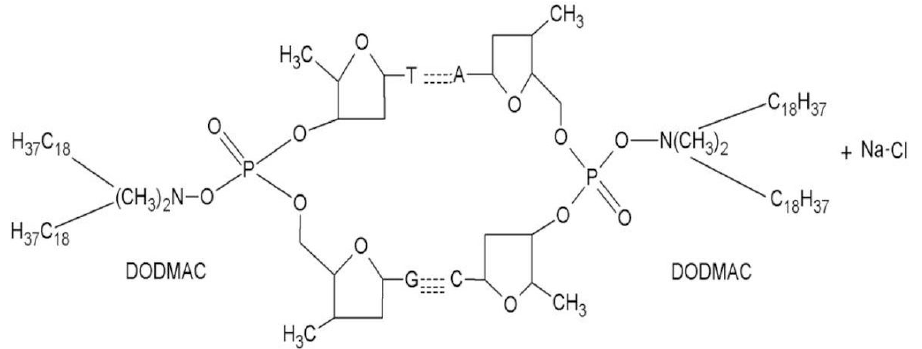
Figure 1. DNA structure with a surfactant DODMAC, where: A, T, G and C—four nitrogen-containing nucleobases and hydrogen bonds bind the nitrogenous bases of the two separate polynucleotides.